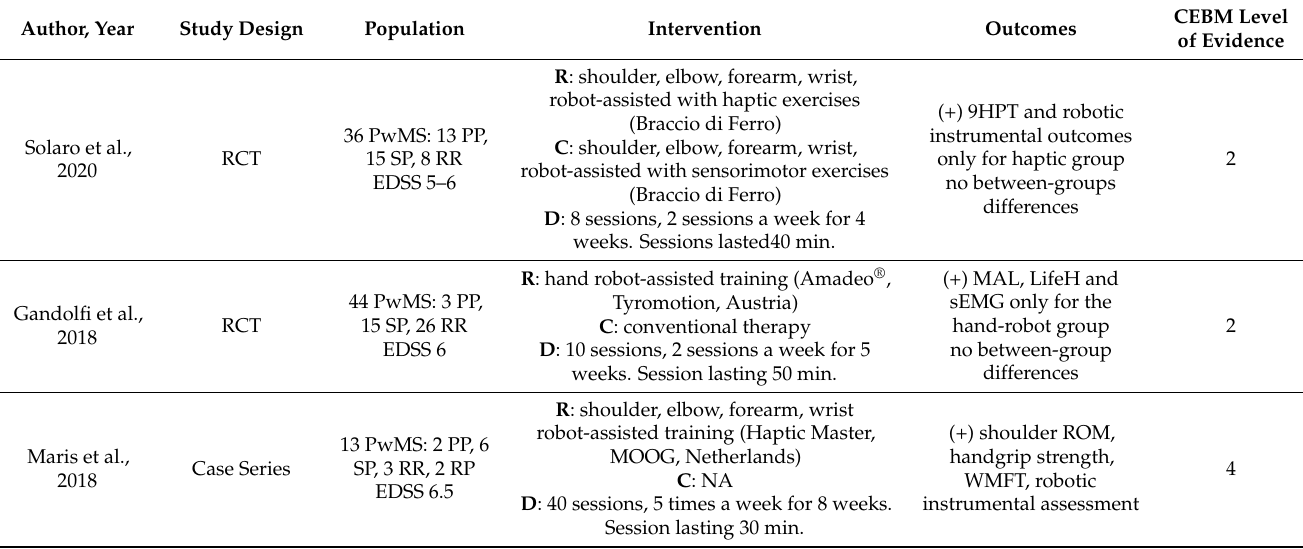
Table 1. Main characteristics of the studies included in this review and related CEBM levels of evidence.